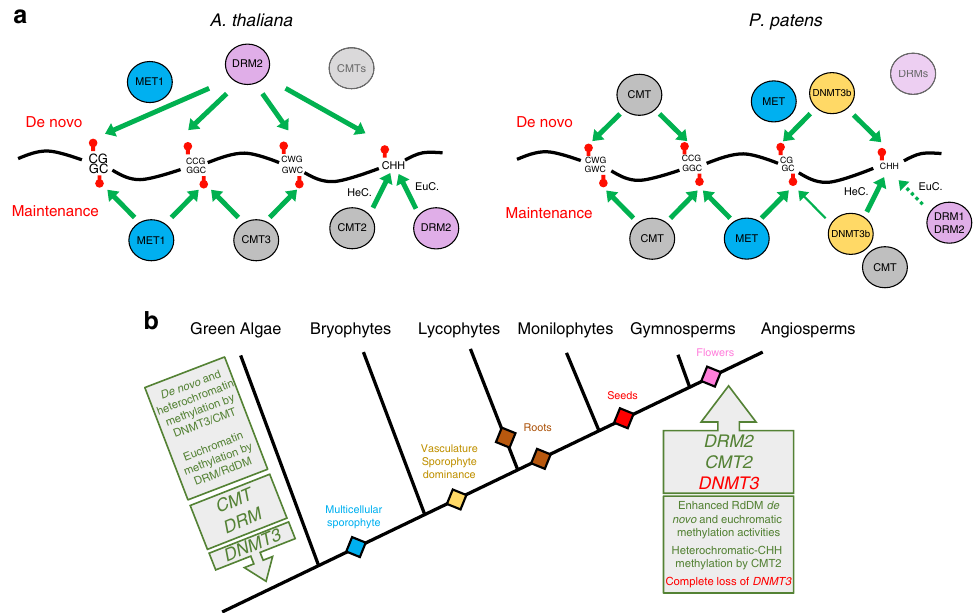
Fig. 5 Mechanisms and evolution of plant DNMTs. a DNMT methylation mechanisms are illustrated based on current knowledge. Black line represents the DNA with different cytosine subcontexts embedded in it. Lollipops represent methylation. Arrows width is corresponding qualitatively to the relative level of methylation mediated by indicated DNMTs. HeC. = heterochromatin, EuC. = euchromatin. De novo and maintenance methylation activities are shown above and below the DNA, respectively. De novo methylation in P. patens is based on our RPS transgene results. Future studies would need to check the de novo methylation activity of CMTs and DRMs (masked ovals) in Arabidopsis (angiosperms) and P. patens (basal/DNMT3-encoding plants), respectively. b Schematic illustration of the evolution of plant DNMTs and their function based on previous and our studies. Backbone of phylogenetic tree is inspired by